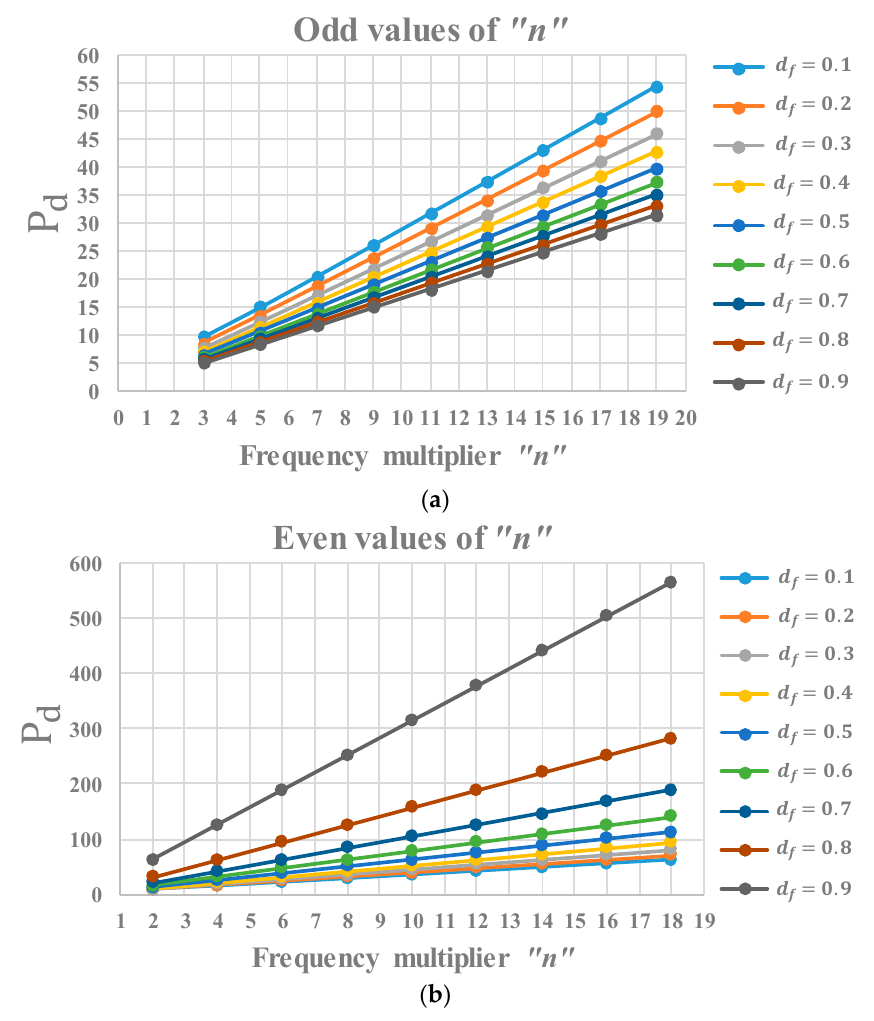
Figure 16. Power demand rate ( P d ) from the power supply for different values of the frequency multiplier “ n ”, same output power (Po = 30 W), and fixed damping factor “ d f ”. ( a ) Power demand rate ( P d ) for odd values of “ n ”. ( b ) Power demand rate ( P d ) for even values of “ n ”.